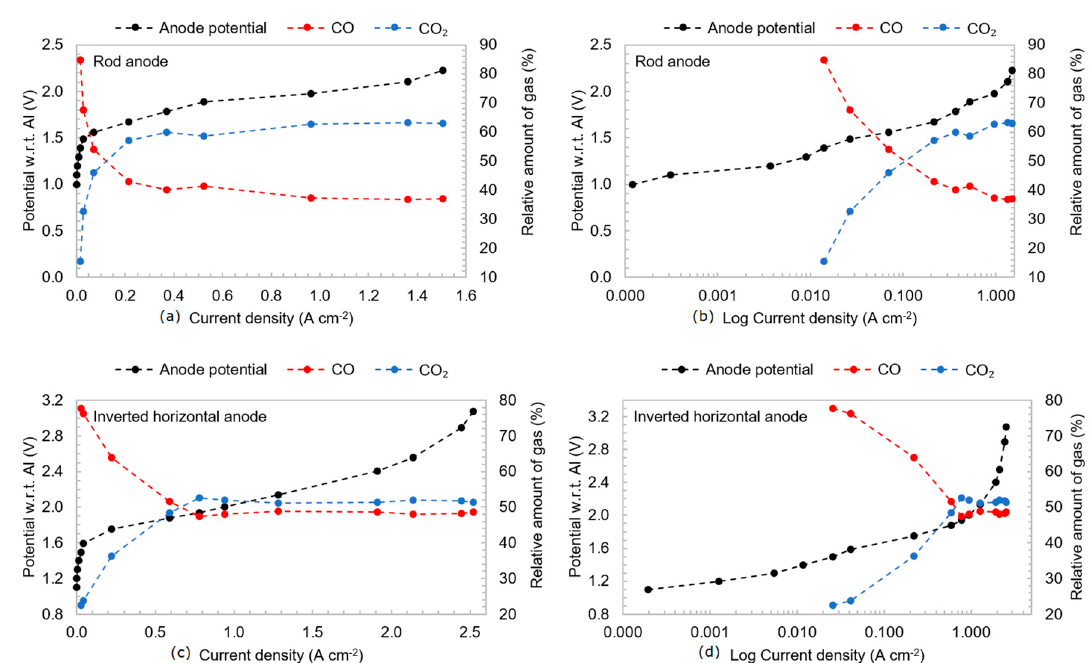
Figure 10. Anode potential and relative amount of the CO and CO 2 gas for the rod anode and inverted horizontal anode versus ( a ) current density (linear scale) for the rod anode, ( b ) current density (logarithmic scale) for the rod anode, ( c ) current density (linear scale) for the inverted horizontal anode and ( d ) current density (logarithmic scale) for the inverted horizontal anode.